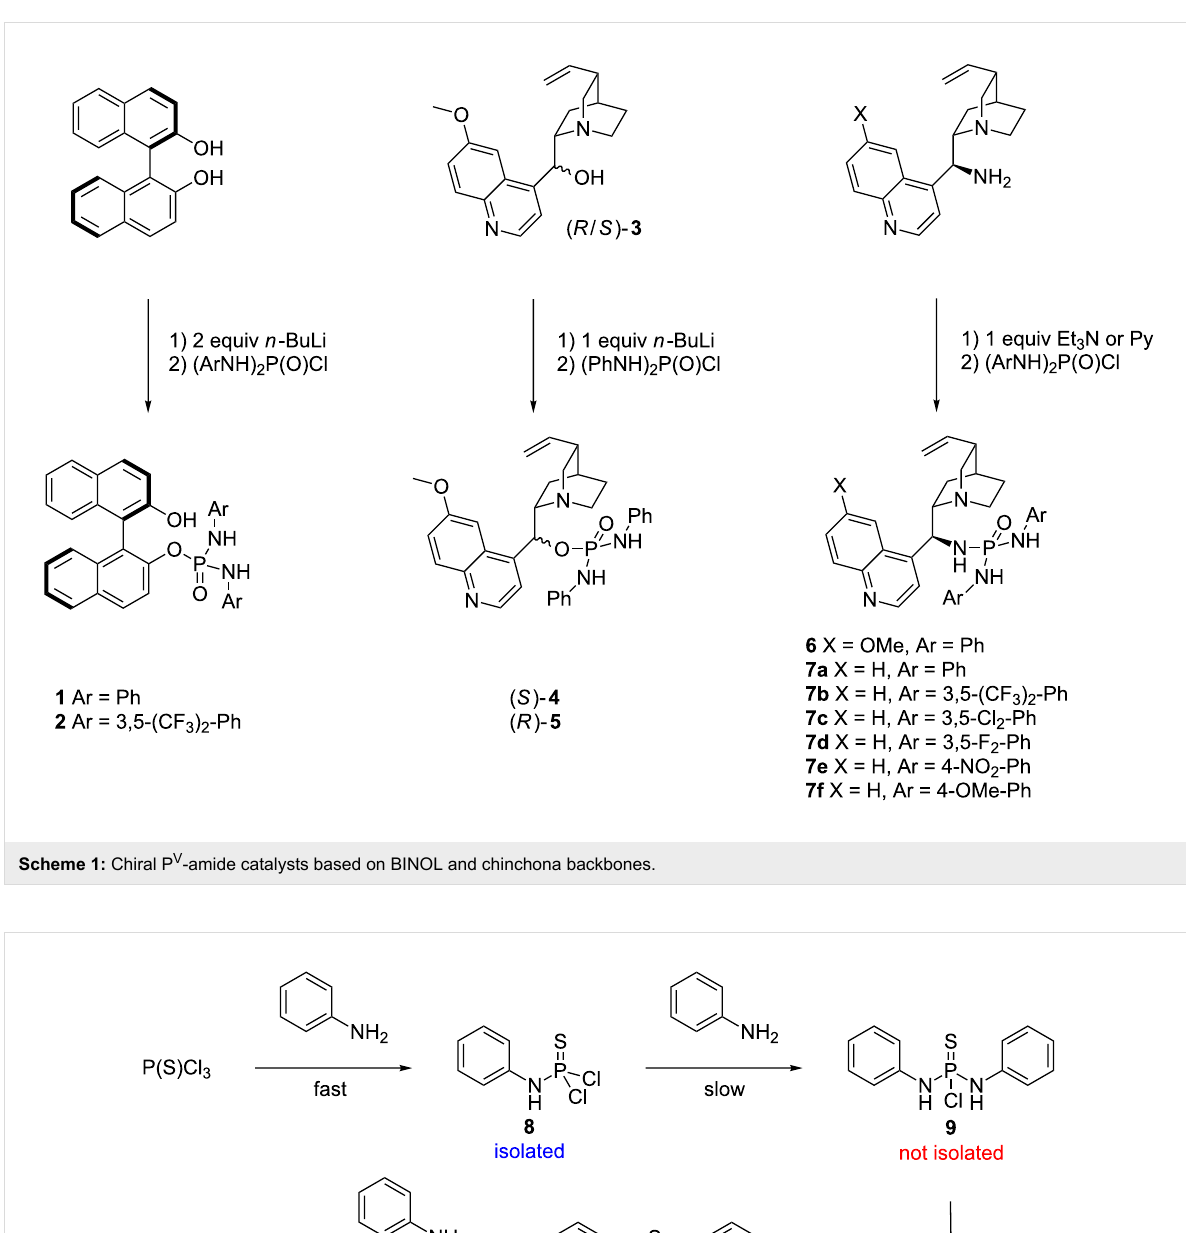
Scheme 2: Exclusive formation of the mono- and trisubstituted product from thiophosphoryl chloride and aniline.